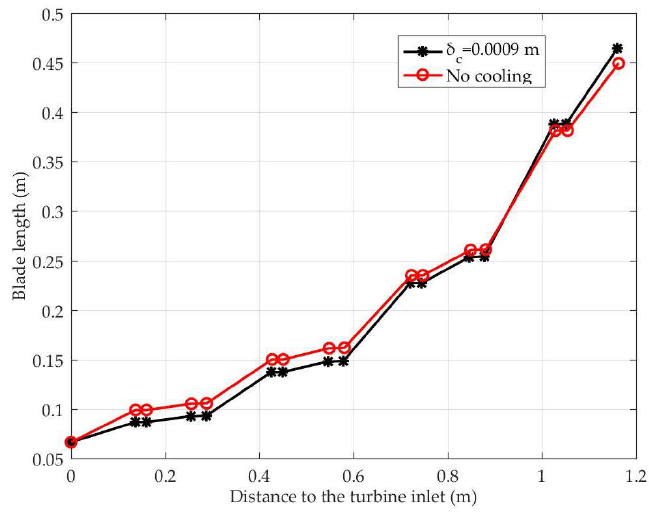
Figure 7. Geometry comparison with and without cooling.